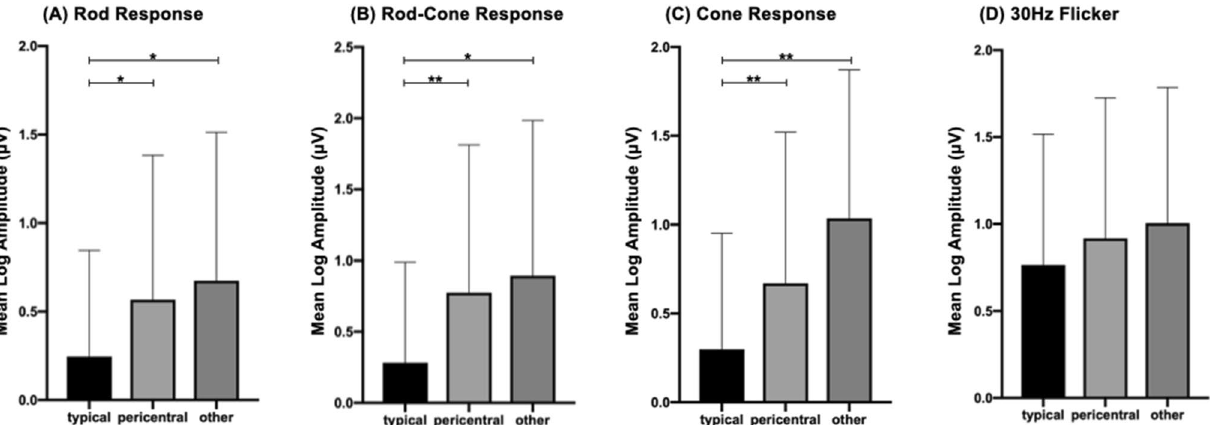
Figure 1. Different electroretinography response amplitudes of different subtypes of retinitis pigmentosa. ( A ) Mean log amplitudes of rod response were 0.246, 0.567, and 0.675 in typical, pericentral and other type, respectively. ( B ) Mean log amplitudes of rod-cone response were 0.283, 0.776, and 0.895 in typical, pericentral and other type, respectively. ( C ) Mean log amplitudes of cone response were 0.300, 0.671, and 1.035 in typical, pericentral and other type, respectively. ( D ) Mean log amplitudes of 30 Hz flicker were 0.766, 0.919, and 1.000 in typical, pericentral and other type, respectively. * p < 0.05; ** p < 0.01 using analysis of variance followed by application of a Sidak